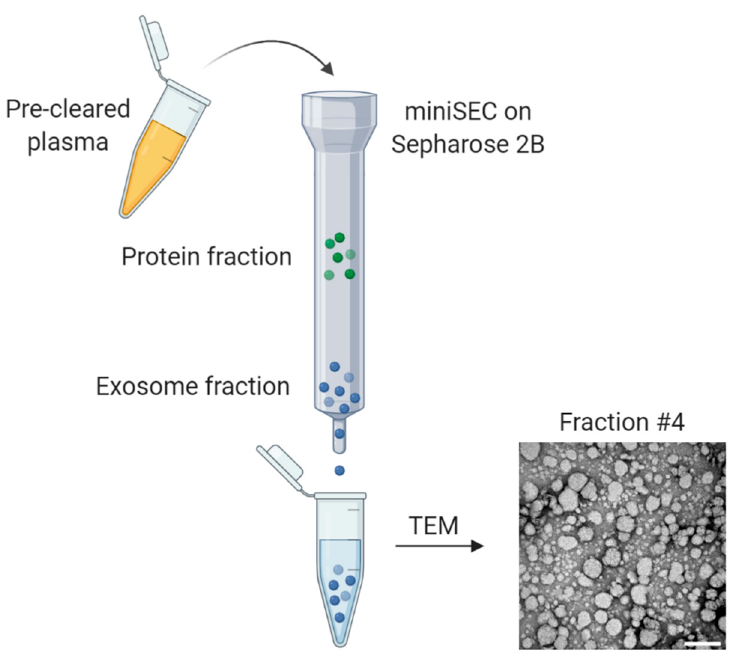
Figure 2. Schematic representation of exosome isolation from plasma using mini-size exclusion chromatography (mini-SEC). Precleared plasma is applied onto a Sepharose 2B column and eluted by serially applying 1 mL PBS. Fraction #4 is enriched in morphologically intact, nonaggregated exosomes as shown in the representative transmission electron microscopy (TEM) picture. Scalebar = 200 nm. Figure is created with BioRender.